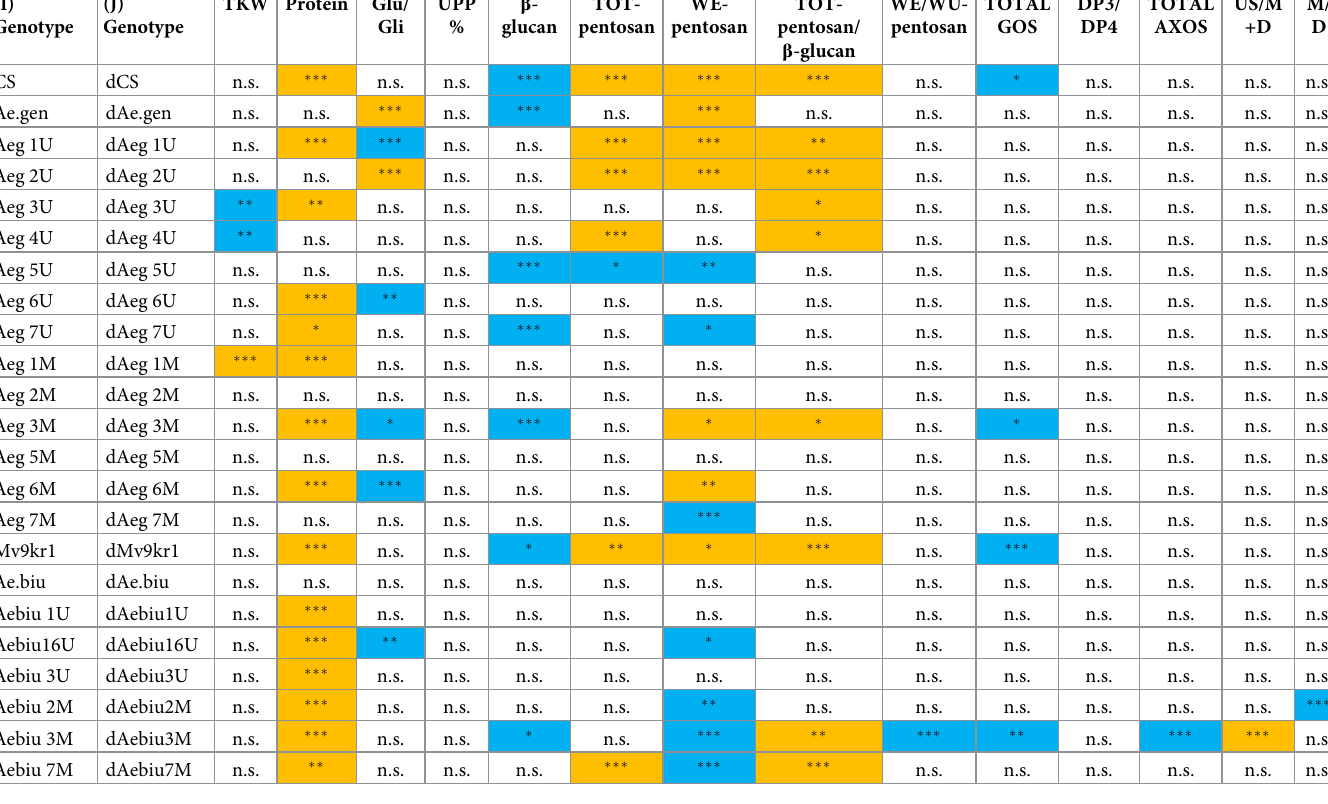
Table 4. Comparison of drought-induced changes in grain composition for each genotype using the Post Hoc multiple pairwise comparison test. Orange and blue blocks indicate values higher and lower than the control,